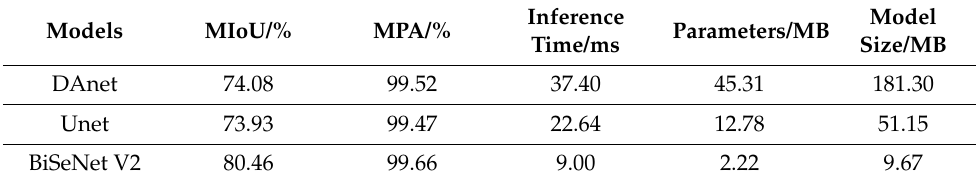
Table 2. The comparison of different semantic segmentation models.